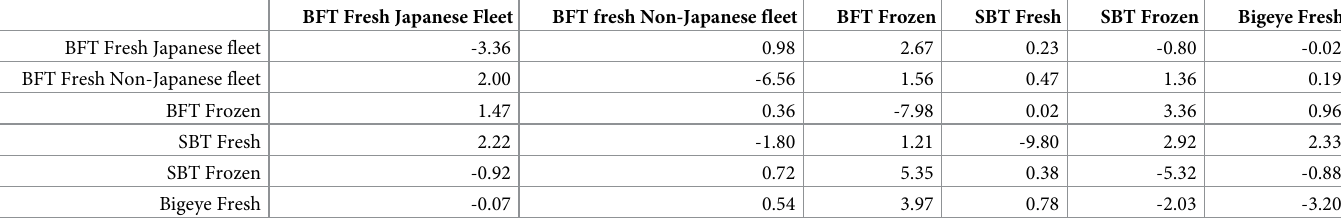
Table 5. Reciprocals of price